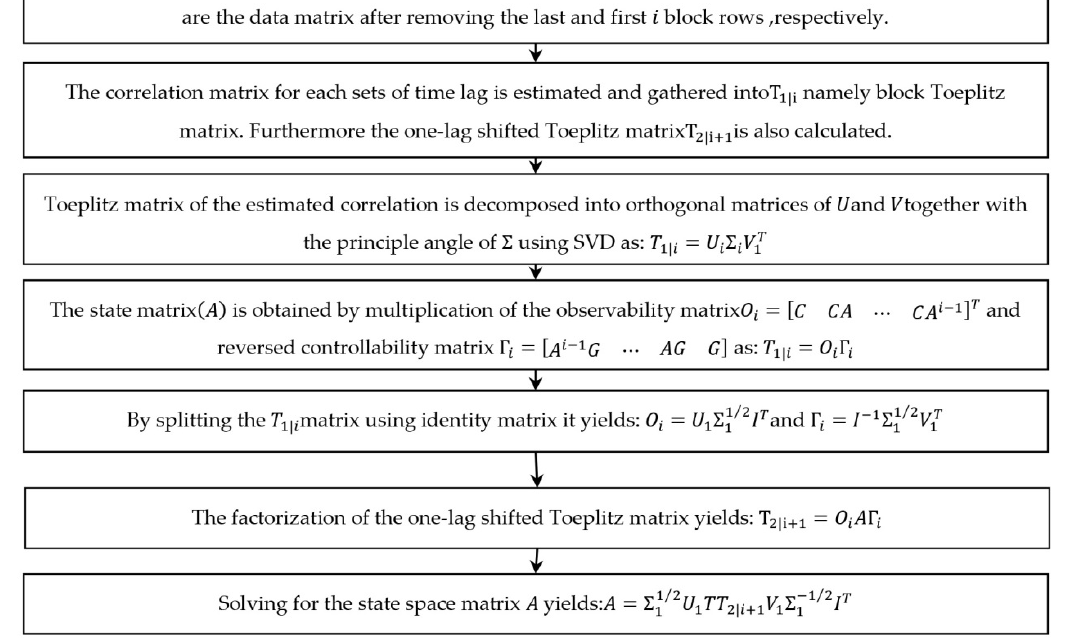
Figure 2. Methodology of the covariance-driven stochastic subspace identification (SSI-COV) technique.